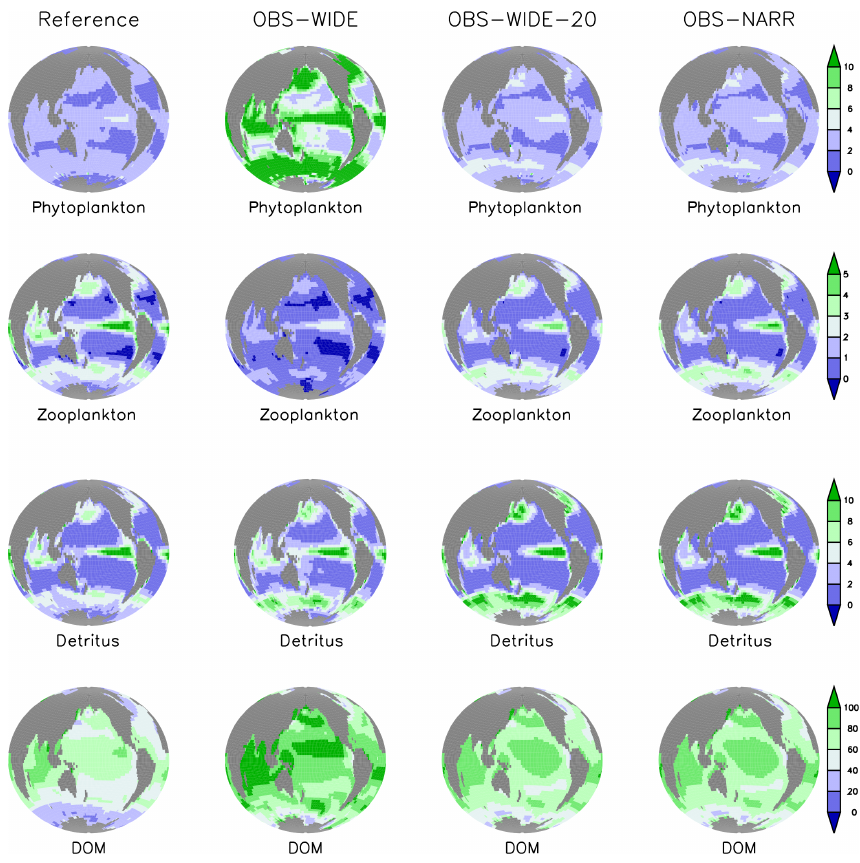
Figure 9. Surface (first) layer concentrations (in mmolCm − 3 , converted via a C:P ratio of 122) for phytoplankton, zooplankton, detritus, and DOM for the reference run and optimizations OBS-WIDE, OBS-WIDE-20, and OBS-NARR.